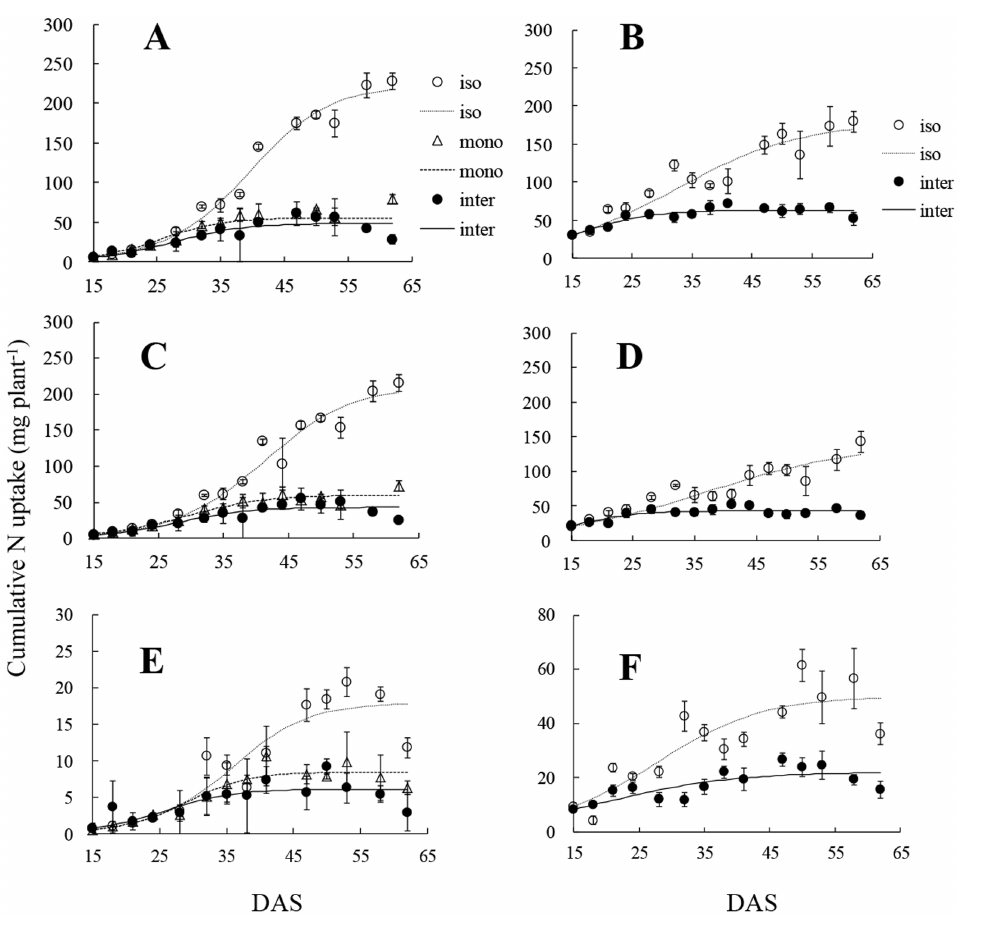
Fig. 3. Cumulative nitrogen (N) uptake. A, B: total plant N uptake of wheat, and faba bean; C, D: shoot N content of wheat, and faba bean; E, F: root N content of wheat, and faba bean. iso: isolated plants; mono: monocropped plants; inter: intercropped plants. Open and solid circles, open triangles indicate the mean of actual data at each sampling. All values represent means ¡ SE (n 5 3). Curves are derived from the logistic equation using the mean of three replicates.